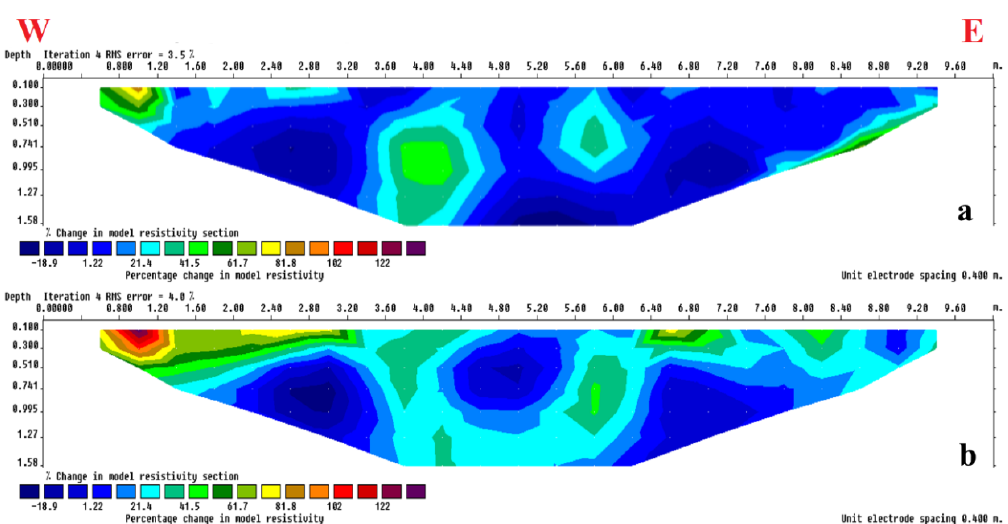
Figure 10. Time-lapse sections showing the percentage change in the subsurface resistivity values, at Farm A, obtained from the joint inversion between the initial model (shown in Figure 6b) as a reference with the lateral datasets collected in ( a ) December 2021 and ( b ) in April 2022.